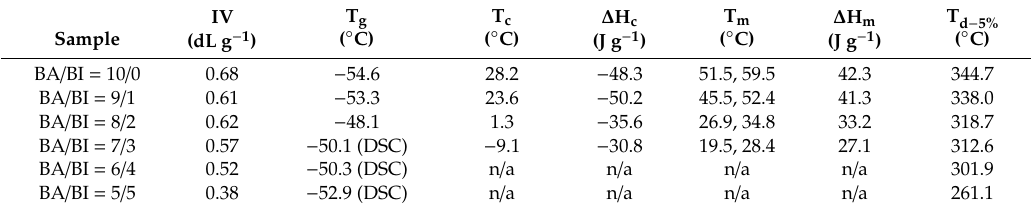
Figure 3. DSC trace of PBABI copolyesters with different BA/BI ratios: ( a ) cooling curves in the first scan, and ( b ) heating curves in the second scan.